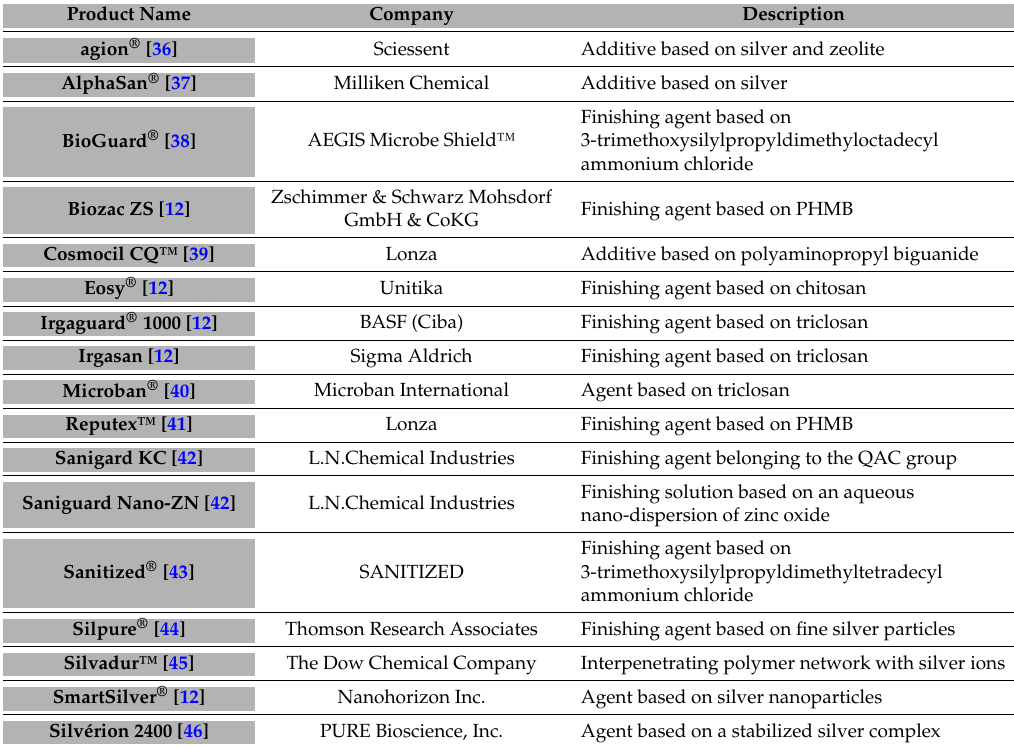
Table 2. Commercially available antimicrobial isolated